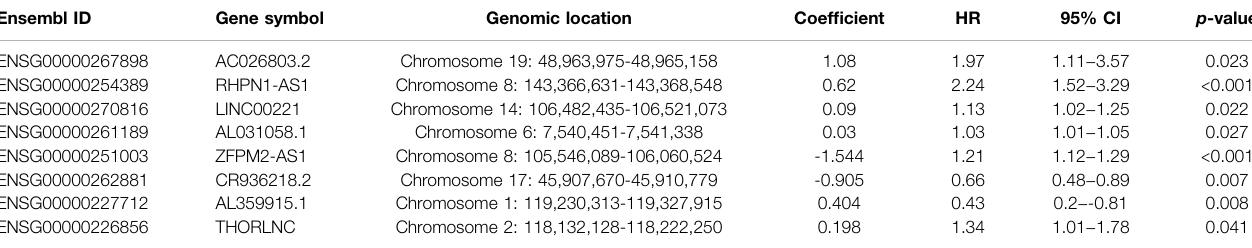
TABLE 2 | Multivariate Cox regression analysis of genome instability-related lncRNAs associated with overall survival in HCC. Ensembl ID Gene symbol Genomic location Coef fi cient HR 95% CI p